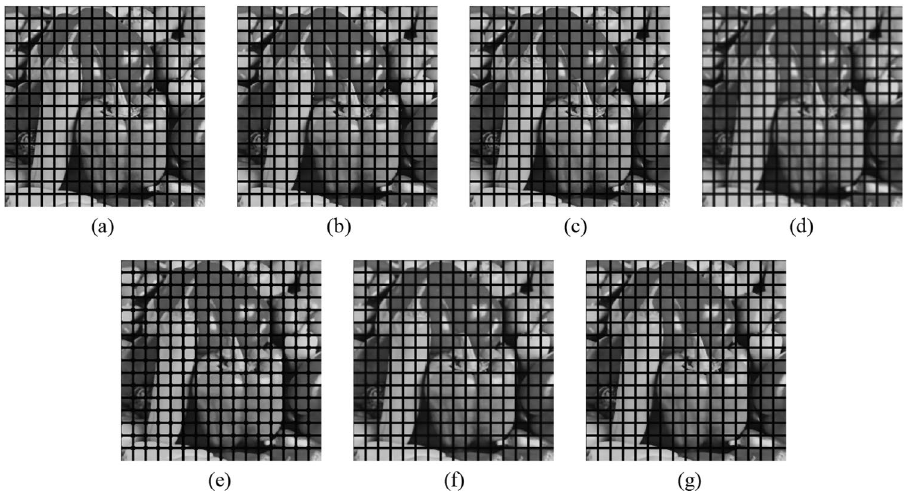
Figure 31. Comparison of edge preservation performance of each filter (“Pepper”). ( a ) Grid-added image; ( b ) filtered image using abwFMGFI; ( c ) filtered image using NLMF (templateWindowSize: 21, searchWindowSize: 7); ( d ) filtered image using GF (σ_x: 5, σ_y: 5); ( e ) Filtered image using MF; ( f ) filtered image using BF (σ_c: 35, σ_s: 5); ( g ) filtered image using ABF (σ_s: 7, max_σ_c: 35).